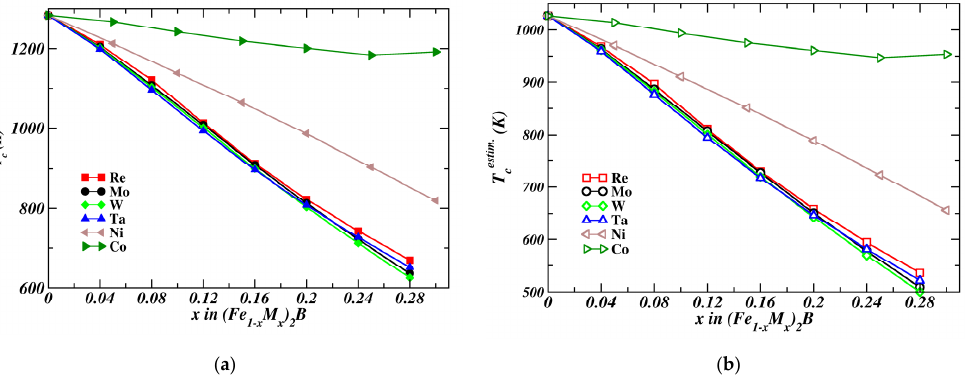
Figure 7. ( a ) The mean field approach (MFA) calculated Curie temperatures for the (Fe 1 − x M x ) 2 B alloys (M = Co, Ni, Mo, W, Ta and Re) and ( b ) the estimated Curie temperatures as T estim c = 0.8 T c